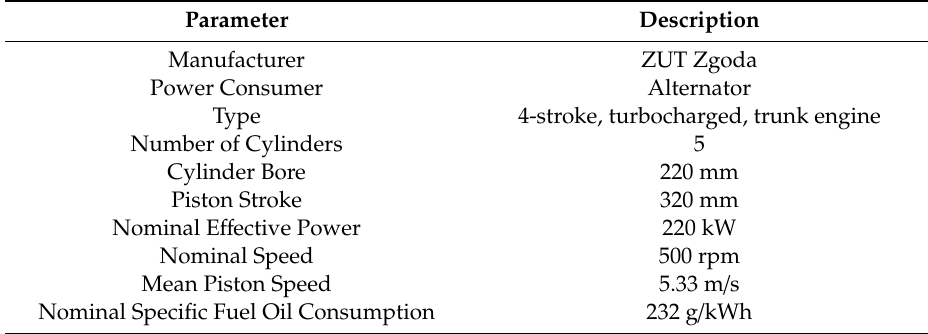
Table 3. The basic technical and operational parameters of a Sulzer 5 BAH 22 Engine.